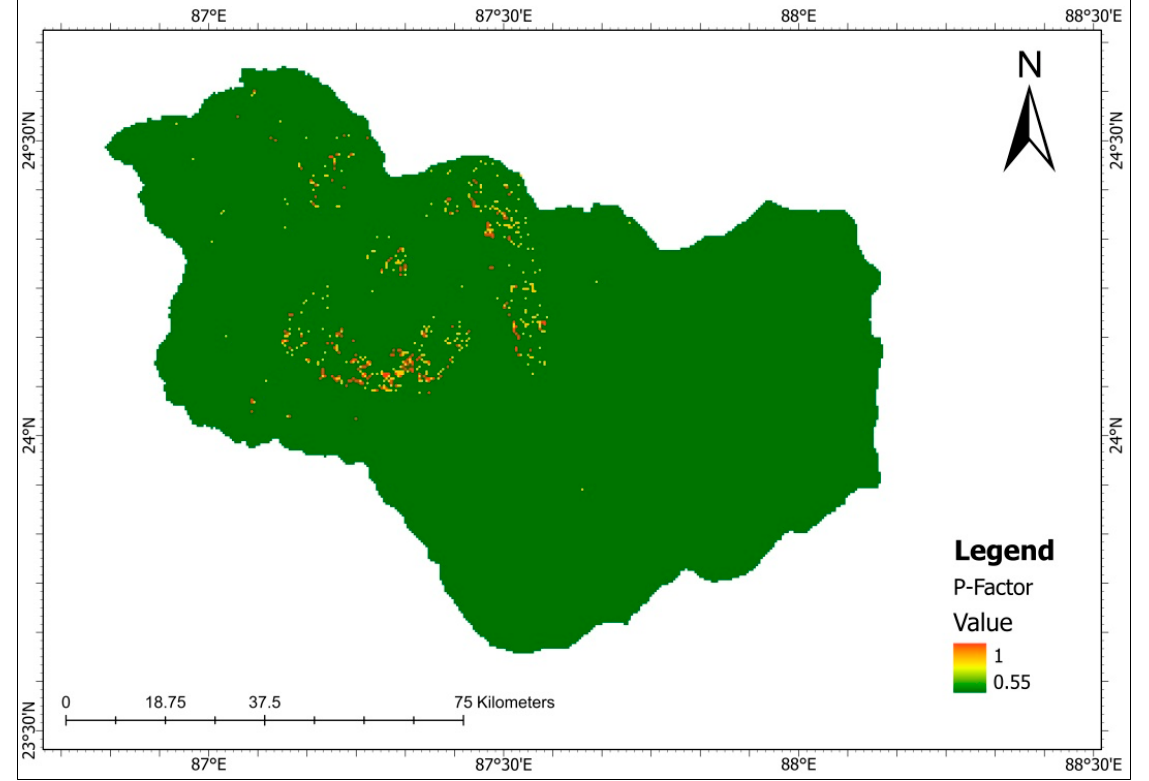
Figure 11. Support Practice Factor (P) map.